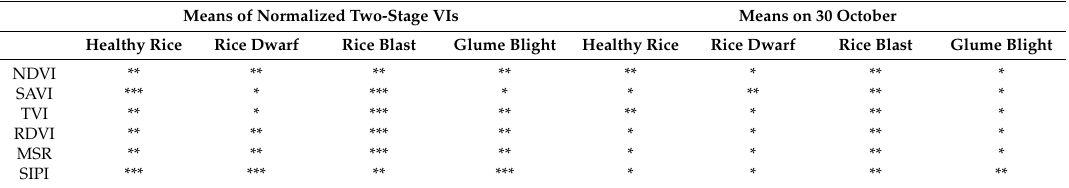
Table 3. A comparison of the independent classification abilities of selected spectral features. Means of Normalized Two-Stage VIs